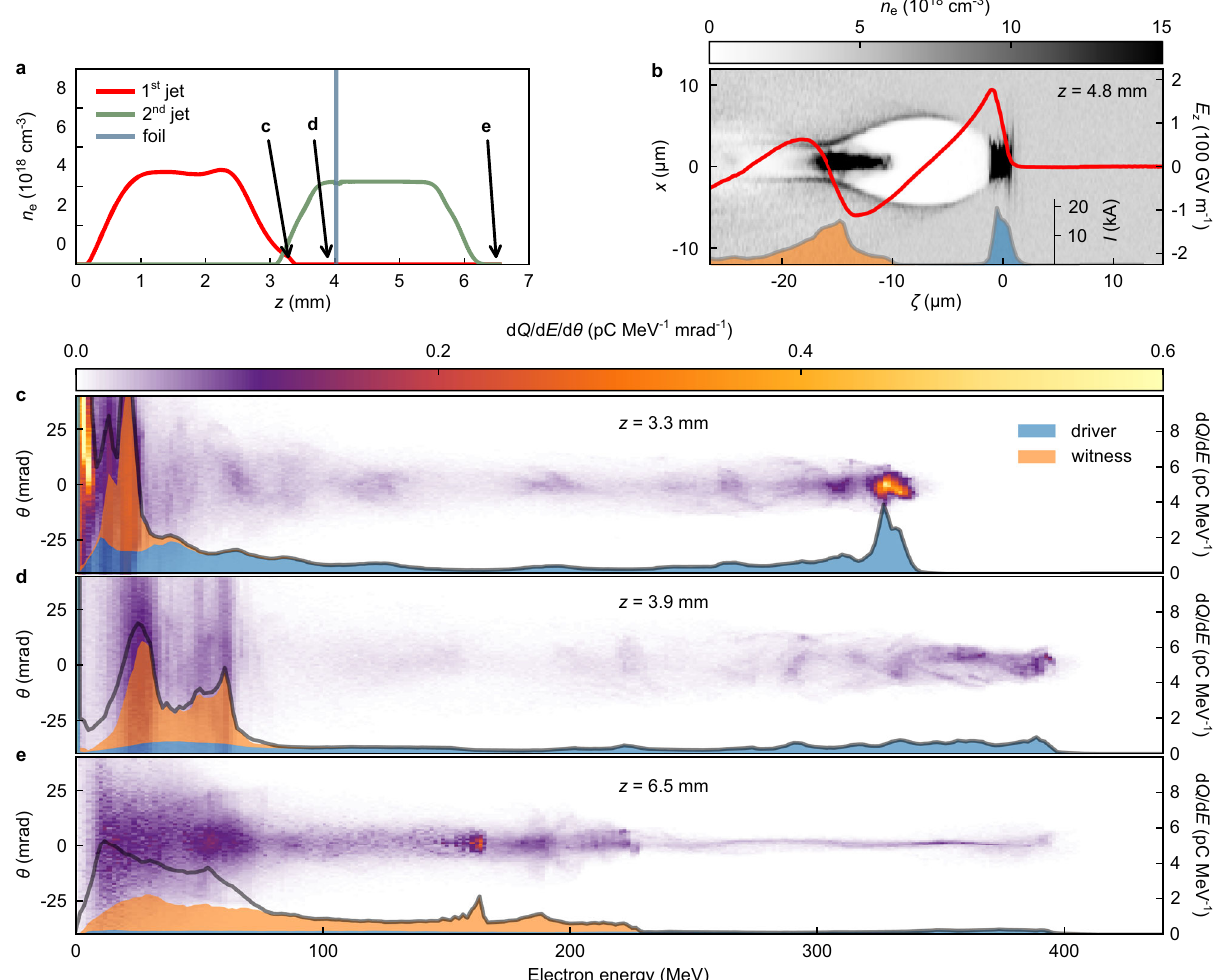
Fig. 3 Start-to-end simulation for the pre-ionized case. a Plasma density pro fi le in the simulation, according to the actual experimental geometry and measured density pro fi les for both gas jets. The drive laser pulse propagates to the right. b Electron density distribution in the PWFA stage, 0.8 mm after the foil. The LWFA electron beam excites a plasma wake fi eld, with the witness beam accelerating at the back of the fi rst cavity. ζ = z − ct represents the co-moving coordinate parallel to the drive beam propagation direction z , with c and t denoting the speed of light and time, respectively. The red line is the on-axis longitudinal electric fi eld and the shaded areas on the bottom show the current pro fi les of the driver (blue) and witness beam (orange). c Simulated electron spectrum after the LWFA stage ( z = 3.3 mm), showing a similar peaked energy distribution of the drive beam (blue) as measured in the experiment. d Just before the foil ( z = 3.9 mm), the wake fi eld driven by the spent laser pulse leads to an energy gain of the LWFA electrons. e After the PWFA stage ( z = 6.5 mm), a strong degradation of the driver along with energy gain of the witness beam (orange) is